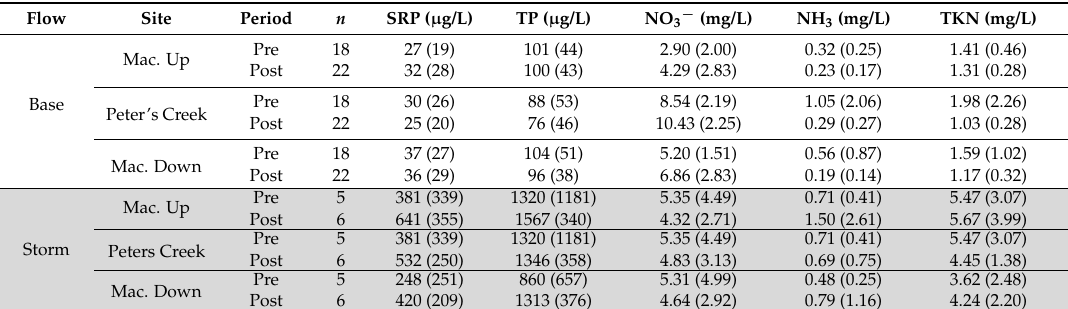
Table 5. Grand means (1 SD) of nutrient concentrations at the Middle Macatawa wetland restoration site. Values in the top half of each cell represent prerestoration (Apr. 2014–Sep. 2015) and values in the bottom half represent post-restoration (Oct. 2015–Nov. 2017). Storm flow data shown in gray shade.